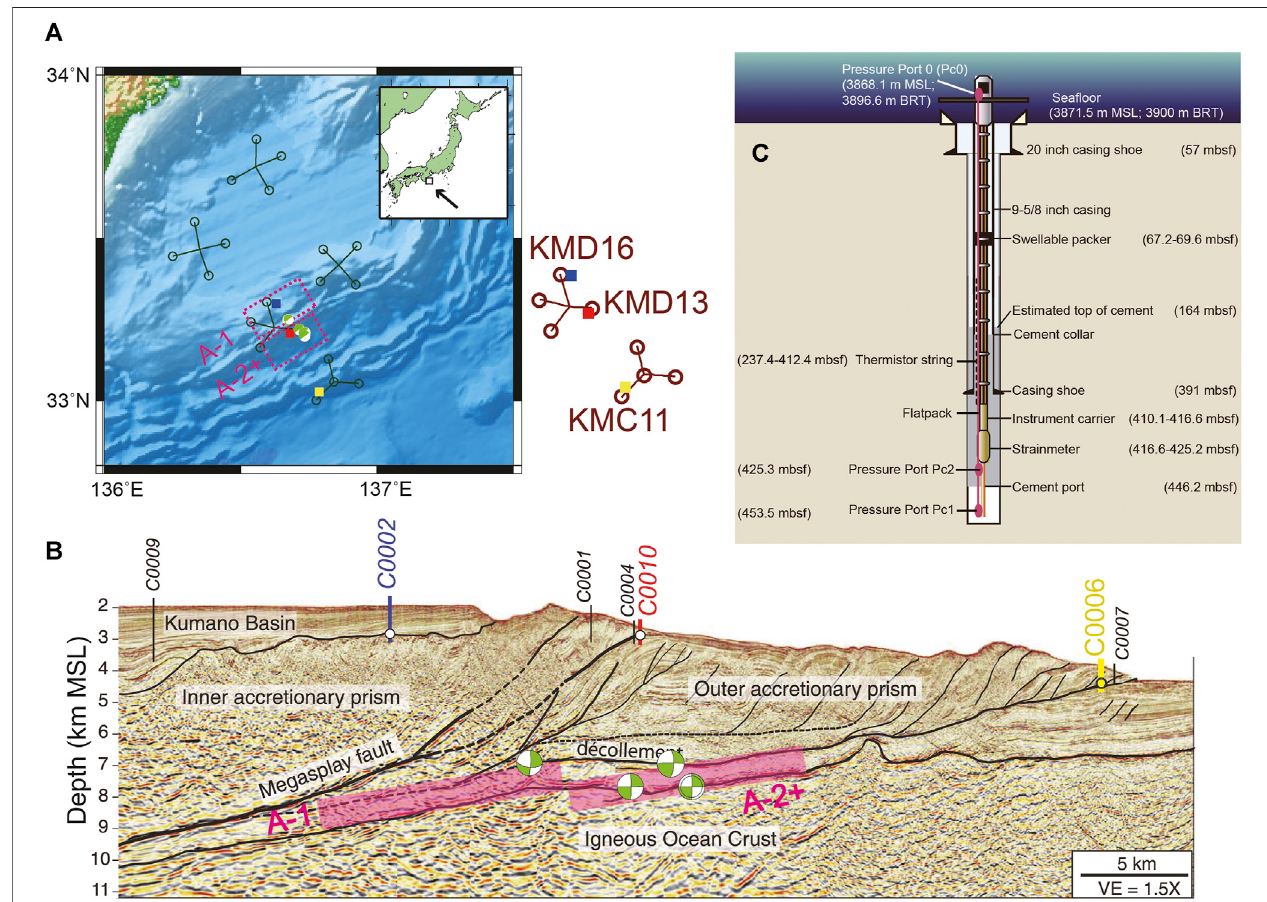
FIGURE 1 | (A) Map of the fault model (A-1, A-2+) of the SSE and sVLFE in March 2020 from previous results (Ariyoshi et al., 2021). Squares represent borehole stations. Labeled names (D-16, D-13, and C-11) are the nearby DONET stations for C0002 (blue), C0010 (red), and C0006 (yellow), respectively. Focal mechanism is obtained from Ariyoshi et al. (2021). (B) Seismic section showing the location of the boreholes C0002 (937 – 980 mbsf), C0010 (610 mbsf), and C0006 (453.5 mbsf), wherembsf (cid:1) meterbelowsea fl oor;VE (cid:1) verticalexaggeration.TheaveragesourcelocationerrorsofsVLFEsare5and2 kmforhorizontalandverticalcomponent, respectively (Nakano et al., 2018). Spatial resolution of focal depth and fi xed dip angle for the SSE is 1 km and 6 ° , respectively (Ariyoshi et al., 2021). The focal depths of thefaultmodelsA-1andA-2+areassumedtobeconsistentwithVLFEbecauseitispracticallydif fi culttodeterminethefocaldepthpreciselyfromonlythetwovolumetric straindataatboreholes(C0002andC0010)byusingthesimpli fi edgreen ’ sfunction. (C) Boreholecompletion diagramat C0006.Thesolidmagentaellipsesindicatethe pressuregauges,wherethetopone(Pc0)isahydrostaticreferencepressuresensorusedtoremoveoceanographicsignals,BRT (cid:1) belowrotarytable,andMSL (cid:1) mean sea level. Figures (B,C) are modi fi ed after Figure 1 of Araki et al. (2017) and Figure 2 of Kinoshita et al. (2018), respectively.